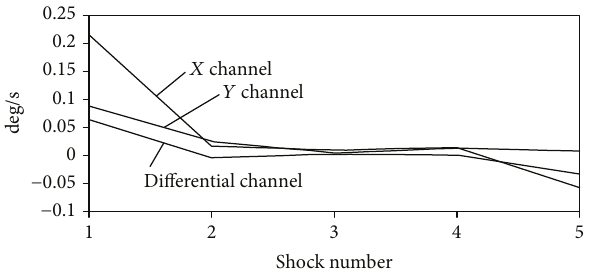
Figure 8: Change of biases after 20 g lateral